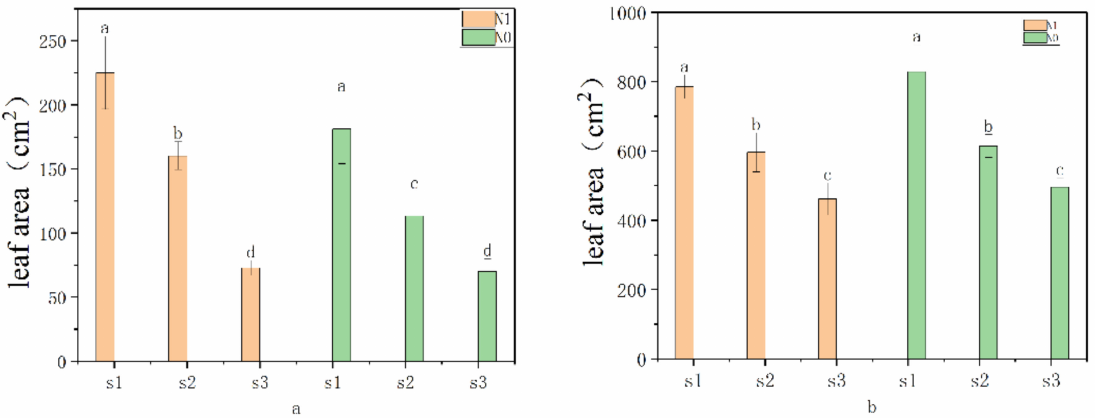
Figure 1. Effects of different nitrogen (N) and salt (S) treatments on leaf area at the stage of twelfth leaf (V12, ( a )) and tasseling (VT, ( b )). The ANOVE results are given for each S and N. Values are means ± standard deviation (SD) per treatment. Different letters indicate statistically significant ( p < 0.05) differences between the treatments using a Tukey post hoc test. N1 is nitrogen application, and N0 is no nitrogen application. S1, S2 and S3 are the soil salinity concentrations of 0%, 0.1% and 0.25%,